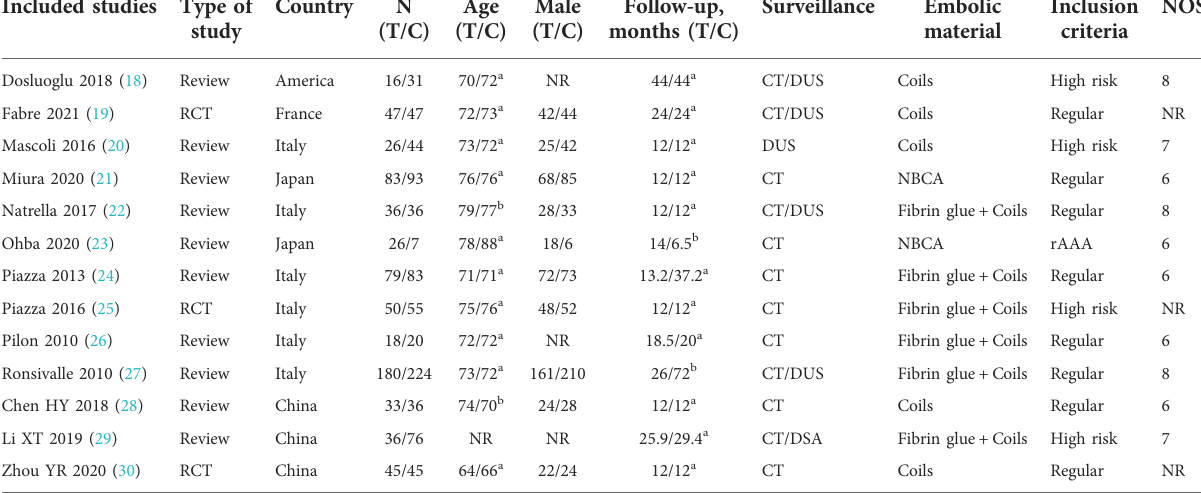
TABLE 1 Baseline characteristics of the included studies.